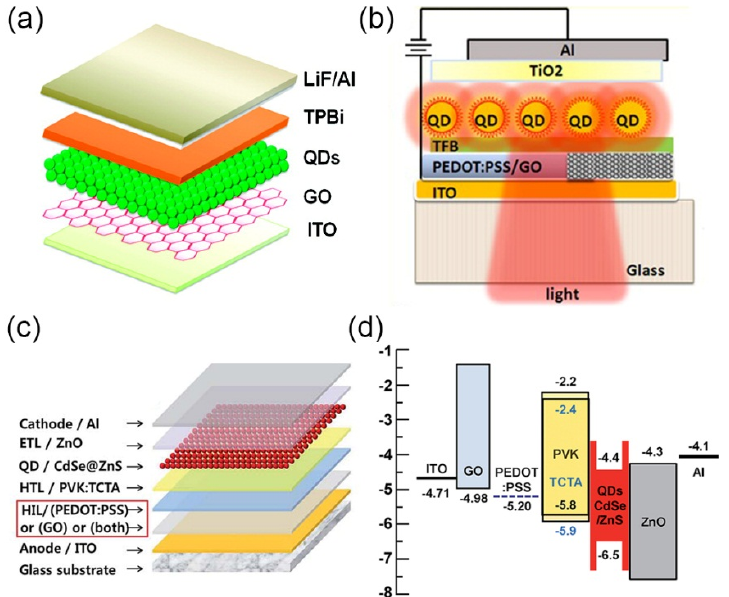
Figure 6. ( a ) Schematic structure of QLEDs with a GO HTL, reprinted with permission from [58], American Chemical Society, 2012; ( b ) Schematic structure of QLEDs with a PDEOT:PSS:GO composite HTL, reprinted with permission from [60], Wiley, 2015; ( c ) Schematic structure and ( d ) energy level diagram of QLEDs with a GO HIL, reprinted with permission from [59], Royal Society of Chemistry, 2017.